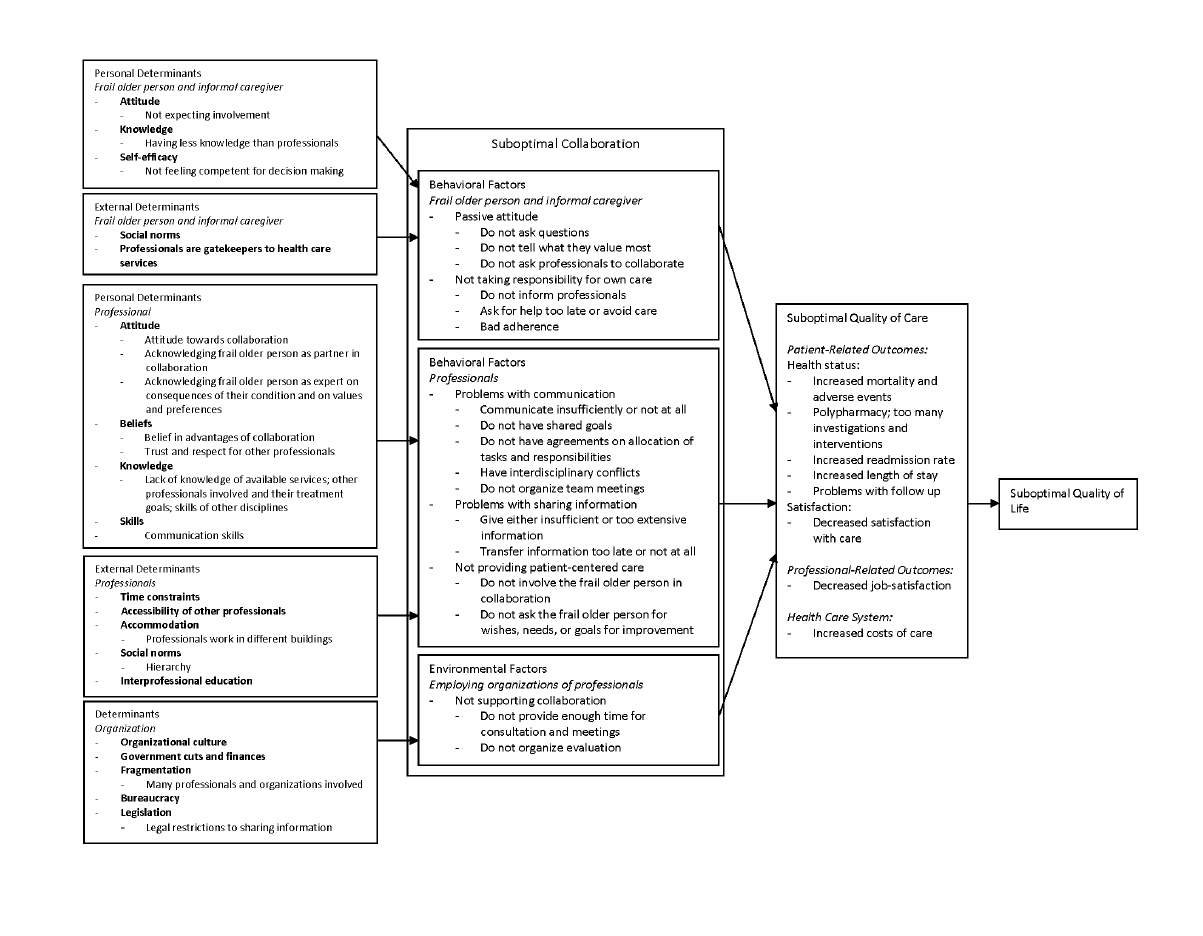
Figure 2. Logic model for collaboration among